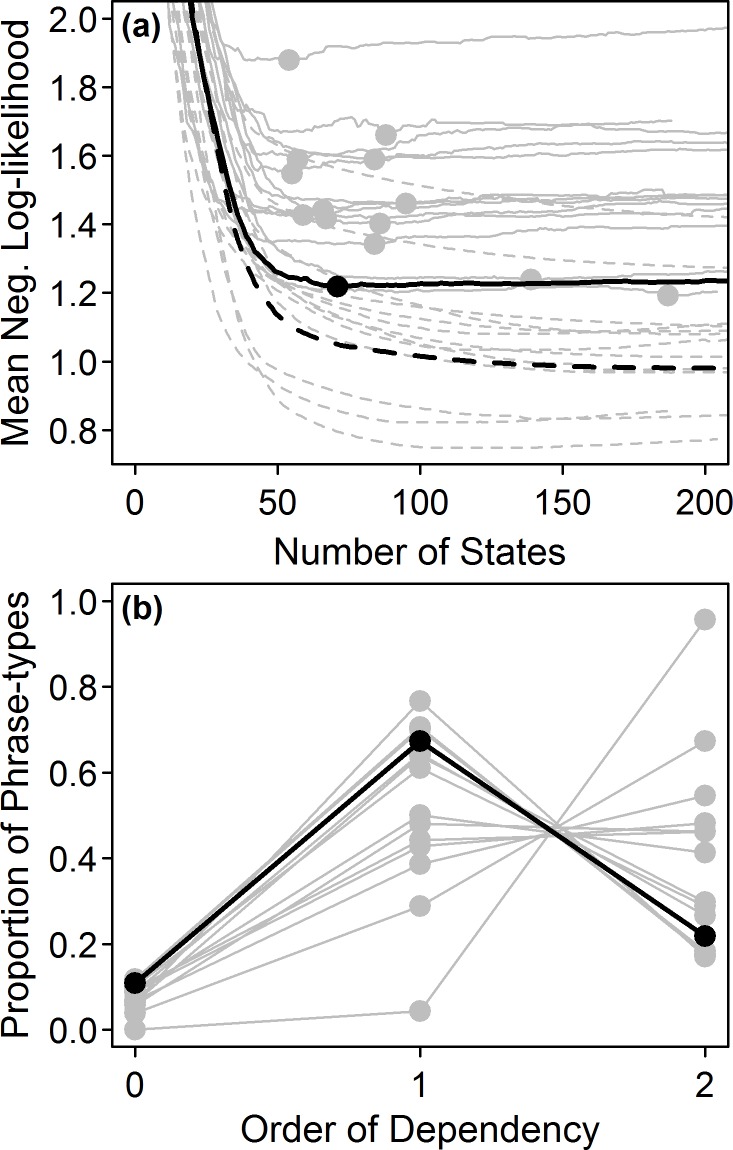
Illustration of the methodology and results of forward selection.Black lines show results for the individual ‘AGBk’; other individuals are shown in gray. (a) states were added to the model by selecting the state providing the largest improvement when applied to the training set (dotted line). The supplemented model was then tested on the testing set (solid line), and the method repeated until all second-order states had been added to the model. The best (interpolated) model was that which gave the minimum negative log-likelihood when applied to the testing set (solid circles). (b) structure of resulting interpolated models, showing the proportion of a bird’s repertoire exhibiting zero-order, first-order and second-order properties.